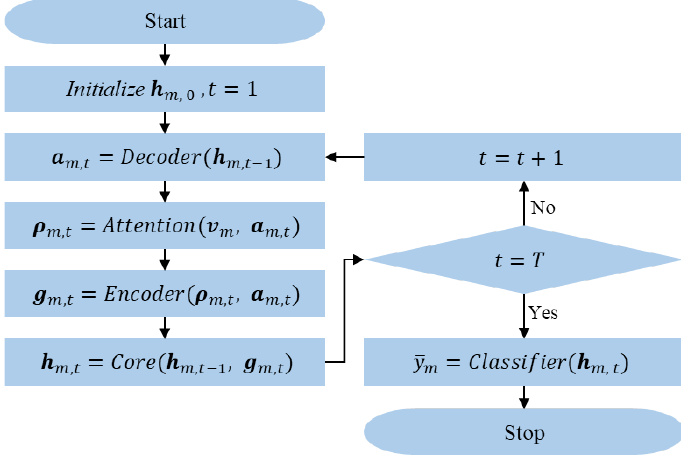
Figure 2. Voice activity detection (VAD) block diagram.